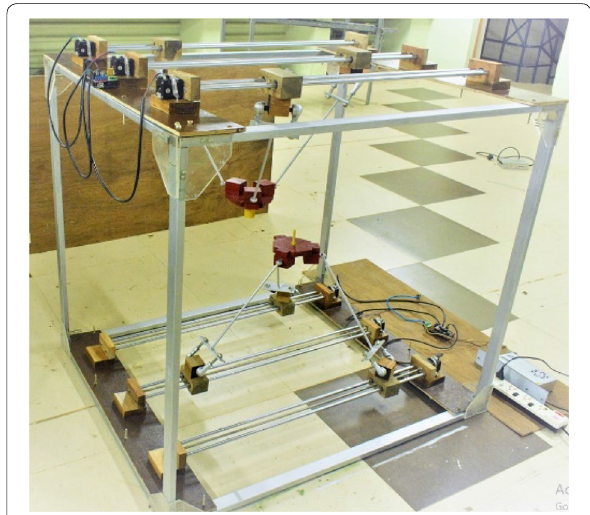
Figure 18 Experimental setup of 3-PRUS dual PKM